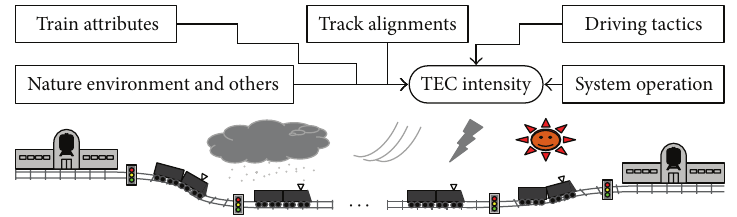
Figure 1: Influence on TEC intensity.